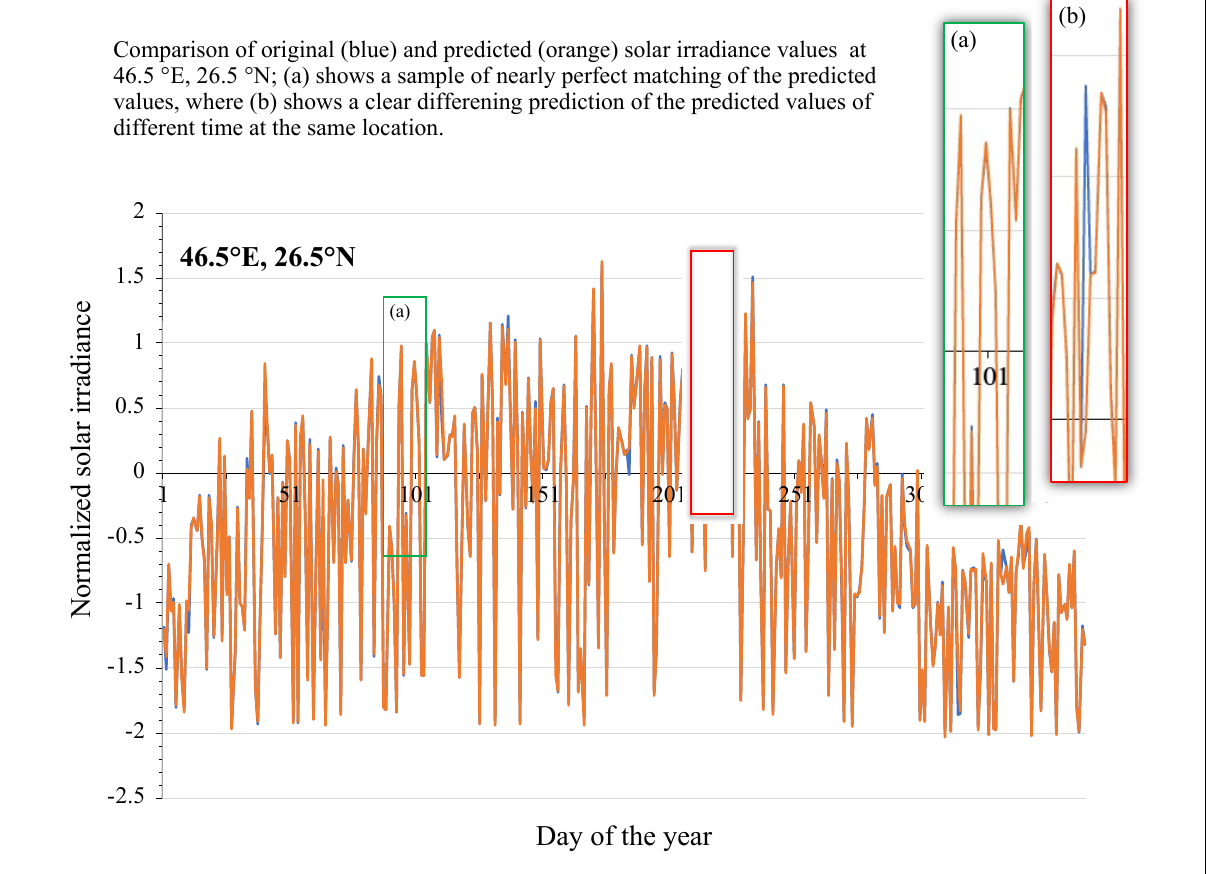
Figure 14. Comparison of original (blue) and predicted (orange) at ( a ) 47.5° E, 20.5° N; ( b ) 50.5° E, 22.5° N